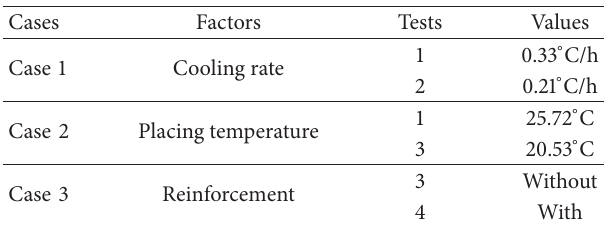
Table 1: Tests parameters and